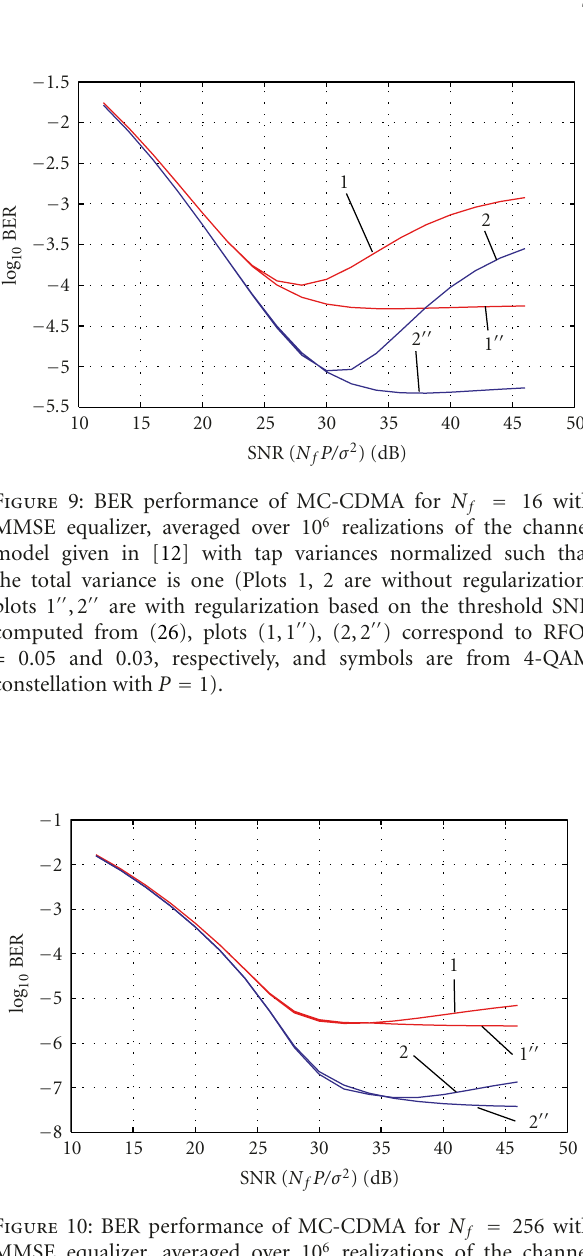
Figure 10: BER performance of MC-CDMA for N f = 256 with MMSE equalizer, averaged over 10 6 realizations of the channel model given in [12] with tap variances normalized such that the total variance is one (Plots 1, 2 are without regularization, plots 1 (cid:7)(cid:7) ,2 (cid:7)(cid:7) are with regularization corresponding to the 5 bins whose gains are least of the 256 bin gains, computing the threshold SNR from (26) by replacing λ min with the corresponding bin gain, plots (1,1 (cid:7)(cid:7) ), (2,2 (cid:7)(cid:7) ) correspond to RFOs = 0.05 and 0.03, respectively, and symbols are from 4-QAM constellation with P =